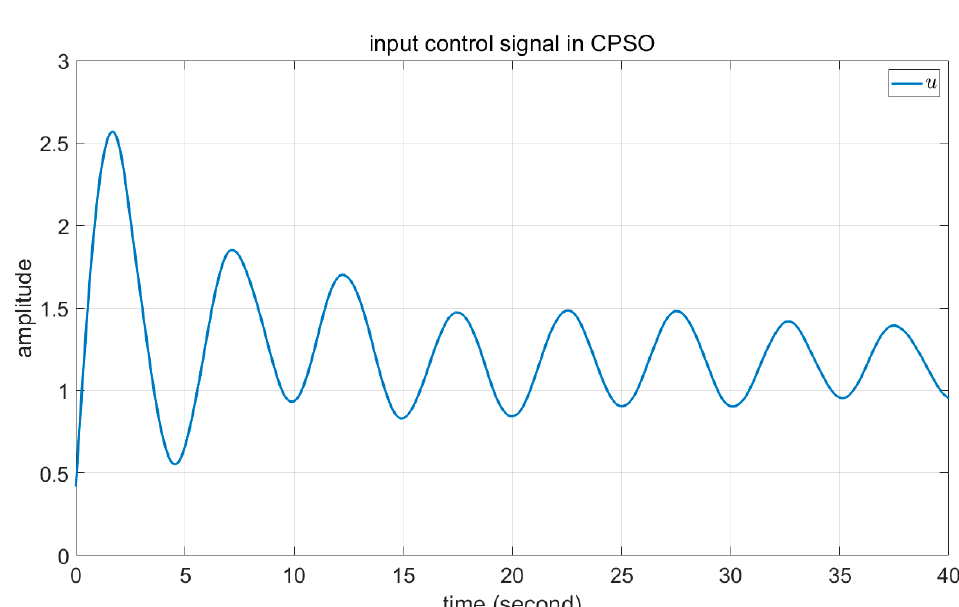
Figure 8. Angular velocity of the rotor in CPSO.